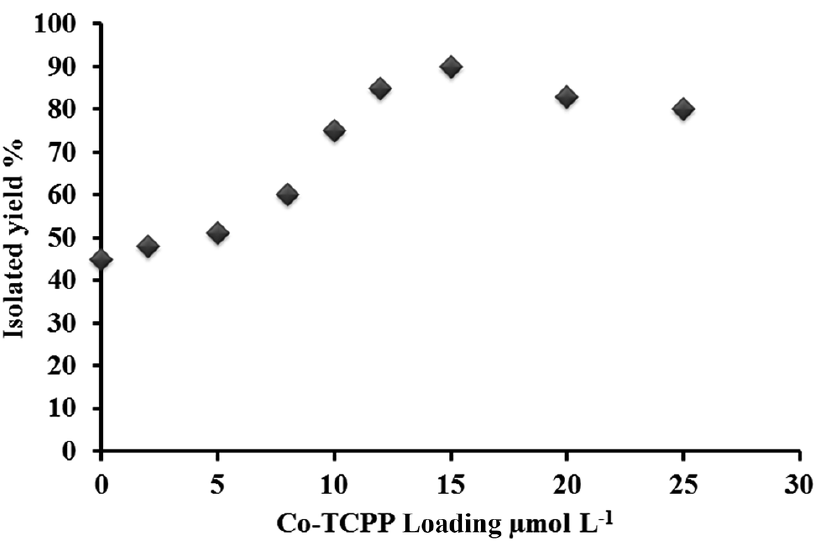
Figure 18. Effect of Co-TCPP loading on the activity of the oxidation reaction of benzaldehyde. Reproduced from reference [83] with permission from the Royal Society of Chemistry, copyright 2016.